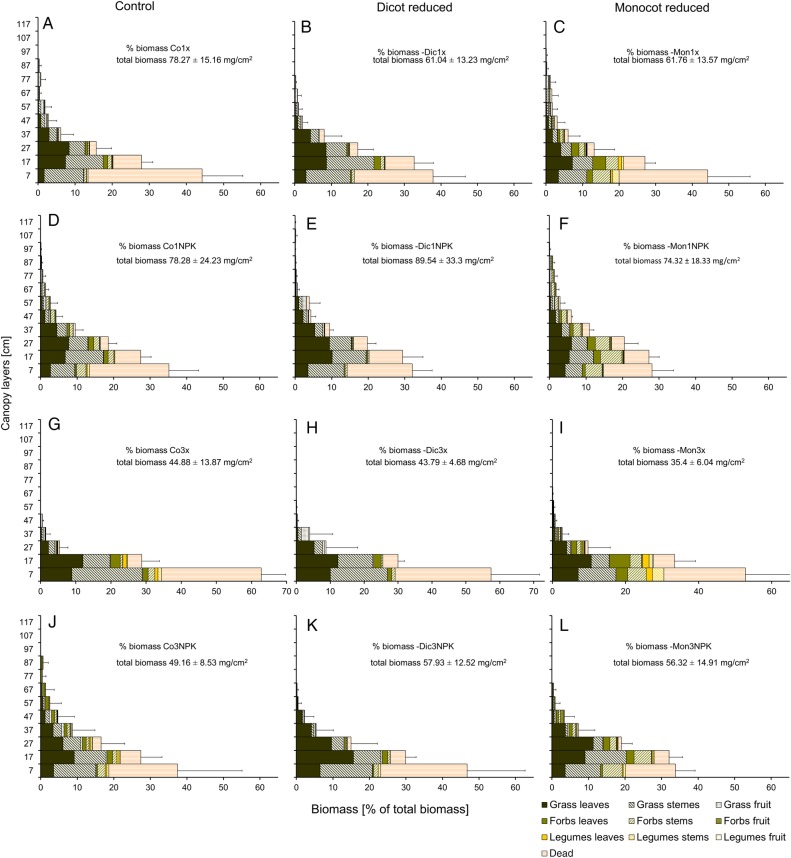
Vertical distribution of the different functional fractions of biomass for all 12 experimental treatments (July 2009). Given are means of total biomass, biomass of each fraction per layer and standard deviations of each layer, n = 6. For abbreviations of treatments, refer to Table 1.